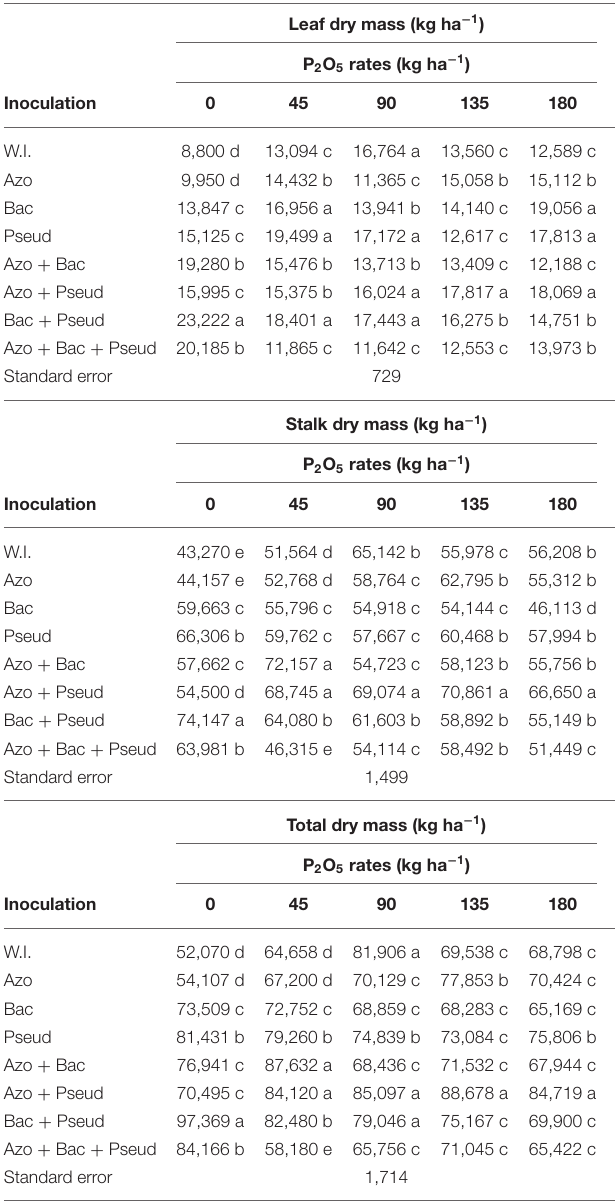
Means followed by the same letter in the column are not statistically different by the Scott-Knott test at 5% probability. W.I., Without inoculation. Azo, Azospirillum brasilense. Bac, Bacillus subtilis. Pseud, Pseudomonas fluorescens. Azo + Bac, A. brasilense + B. subtilis. Azo + Pseud, A. brasilense + P. fluorescens. Bac + Pseud, B. subtilis + P. fluorescens. Azo + Bac + Pseud, A. brasilense + B. subtilis + P.